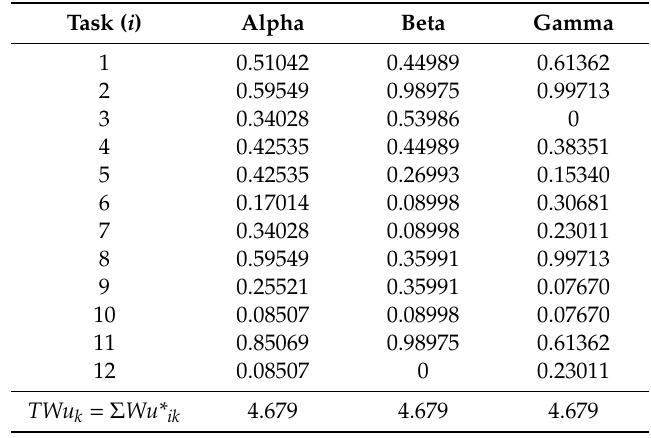
Table 7. New unit workload ( Wu* ik ) per task and model.